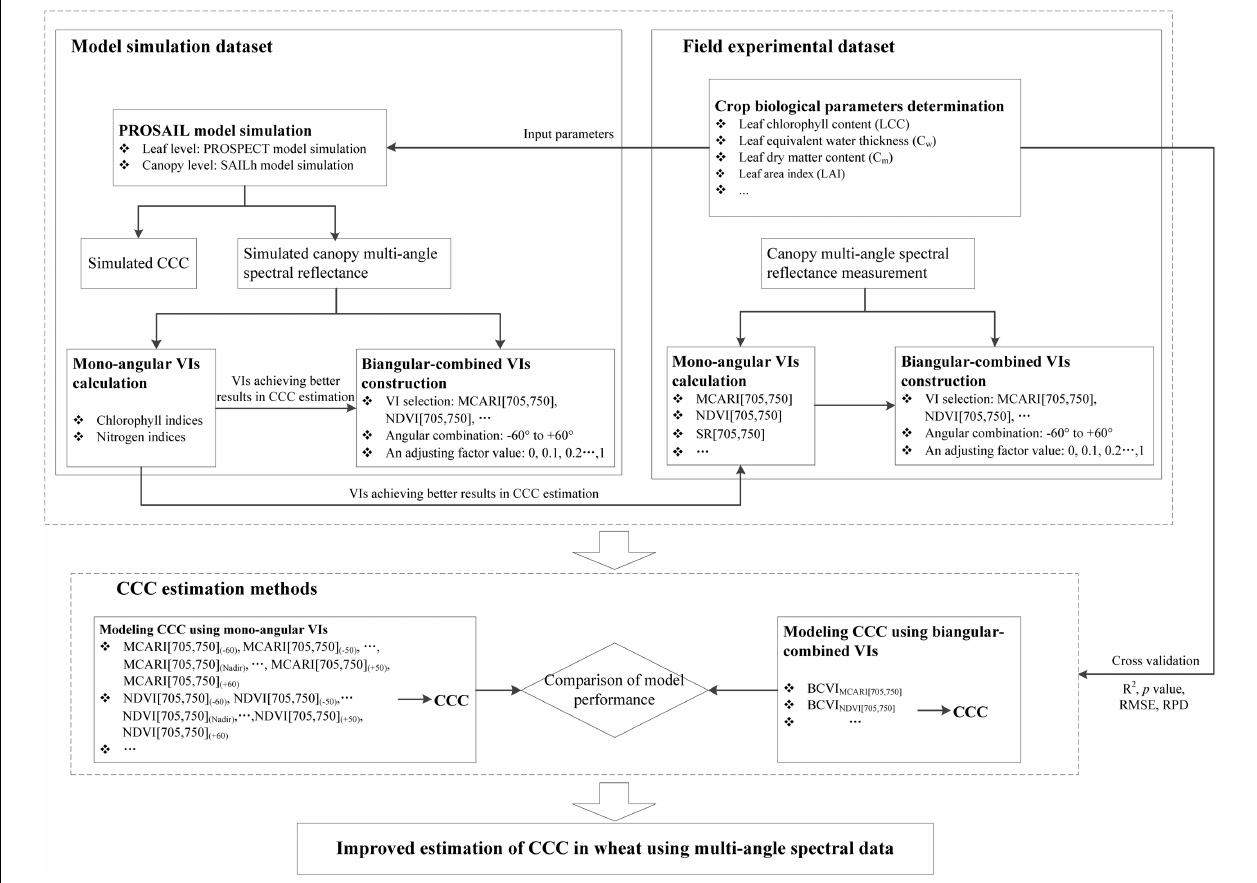
FIGURE 2 | A workflow diagram of canopy chlorophyll content estimation used in this